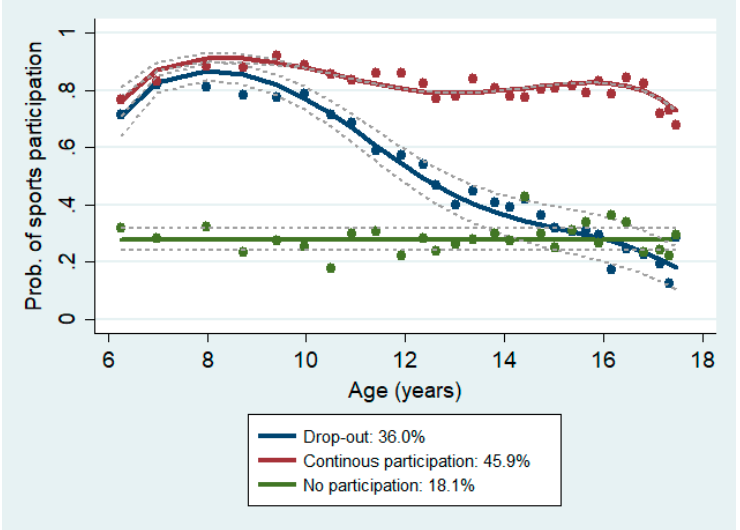
Figure 1. Sports participation trajectory patterns between age 6 and 17 years ( n = 582). Note: Dots indicate actual rates of sports participation, solid lines indicate probabilities of sports participation estimated from trajectory regression models, and dotted lines indicate 95% confidence intervals of the estimated probabilities. The legend presents pattern labels and the proportion of the sample that belongs to the pattern.